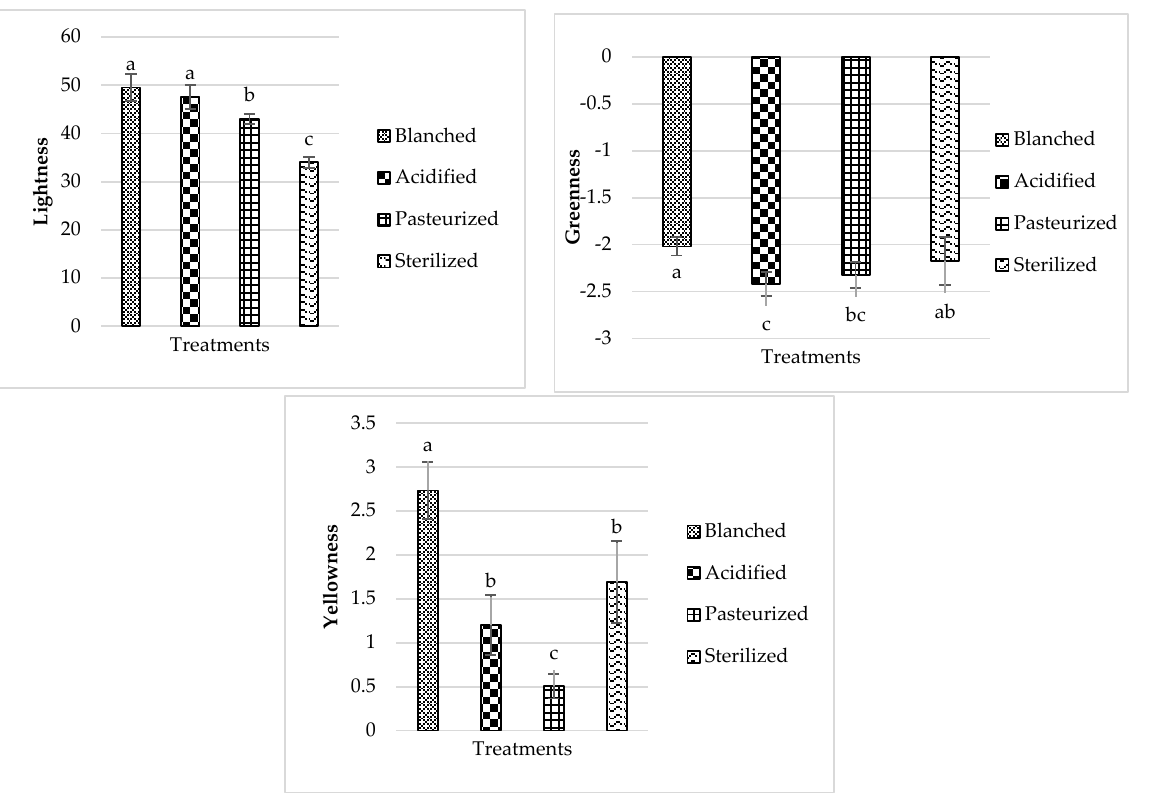
Figure 6. Lightness, redness and yellowness values of turnip samples after different processing steps. Different letters indicate a significant difference ( p < 0.05).